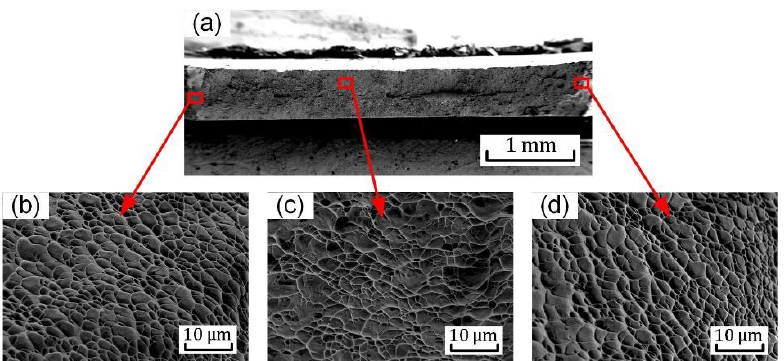
Figure 14. SEM images of feracture surface for the notched (R = 5 mm) tension sample: ( a ) overall view; ( b – d ) high magnification images of the regions highlighted in ( a ).